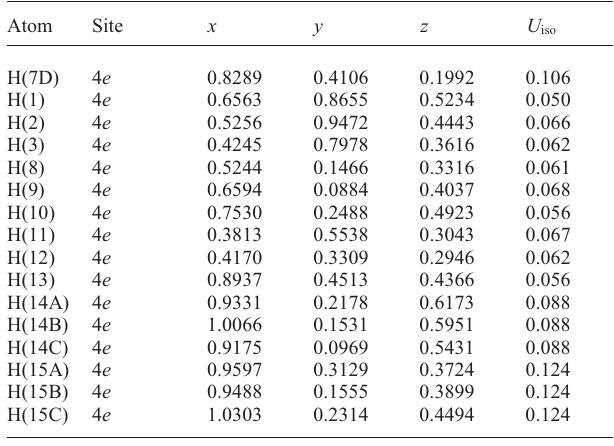
Table 3. Atomic coordinates and displacement parameters (in Å 2 )